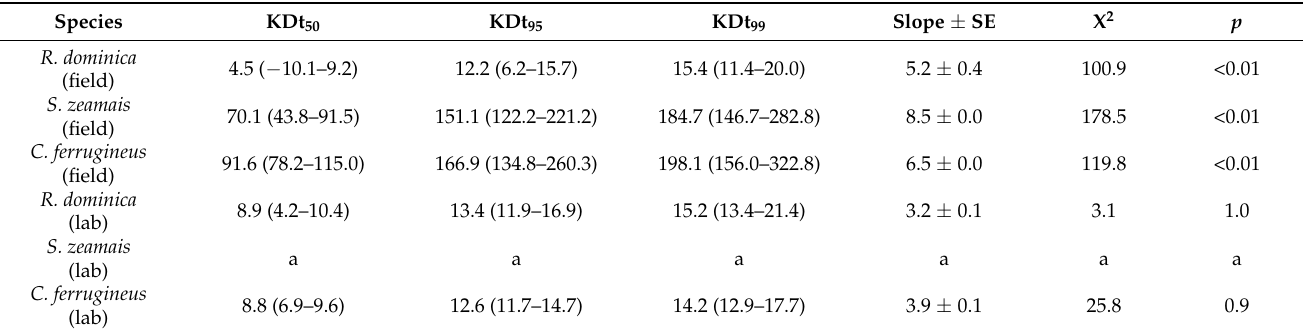
Table 2. Probit Analysis for KDt 50 , KDt 95 and KDt 99 (confidence intervals) of adults after exposure to 3000 ppm concentration of phosphine for the field and laboratory populations examined, expressed as minutes to knock down, using the PTT.